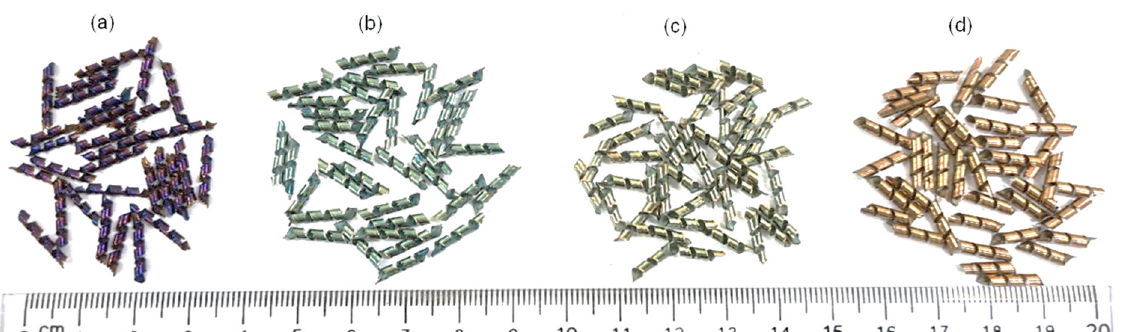
Figure 6. Chip Formation at Di ff erent Temperatures: ( a ) Room Temperature, ( b ) 200 °C, ( c ) 300 °C and ( d ) 400 °C.